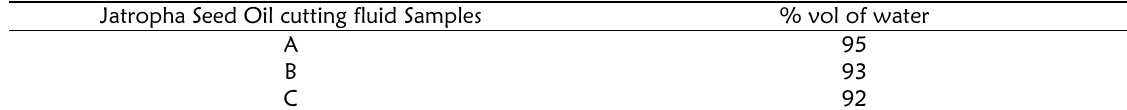
Table 8: Most suitable stability test condition